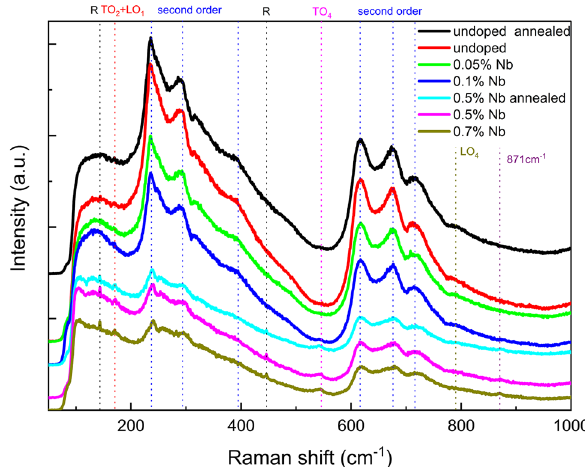
Figure 3. Raman spectra of various Nb-doped SrTiO 3 single crystals at 110